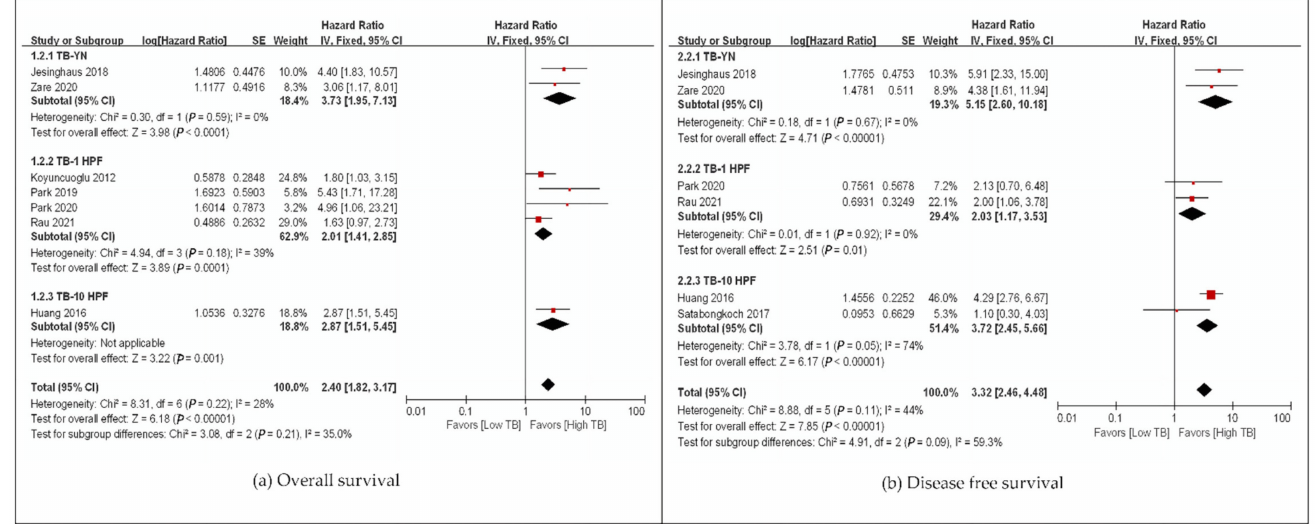
Figure 3. Subgroup hazard ratios analyzing the tumor budding expression, ( a ) overall survival, ( b ) disease-free survival in gynecological cancer patients by assessment method. (cid:4) The location of square epresents the hazard atio and the size means individual effect of studies. The black line represents 95% confidence iterval of the study. (cid:117) The diamond represents pooled hazard ratio and its edge shows 95% confidence